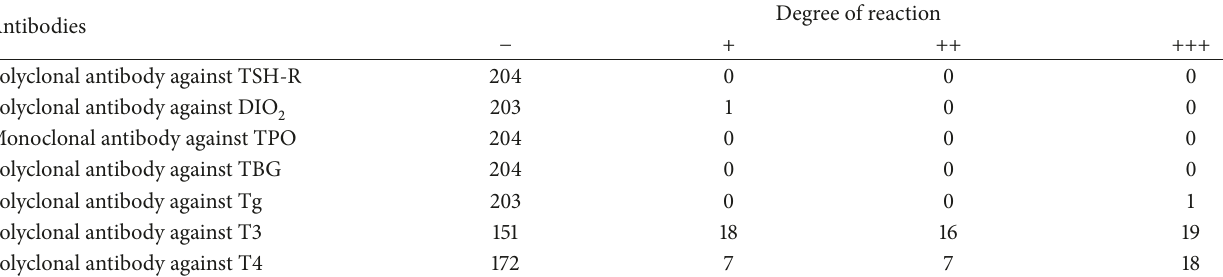
Table 4: Reaction of monoclonal and polyclonal antibodies against 204 different foods. Degree of reaction Antibodies − + ++ +++ Polyclonal antibody against TSH-R 204 Polyclonal antibody against DIO 2 203 Monoclonal antibody against